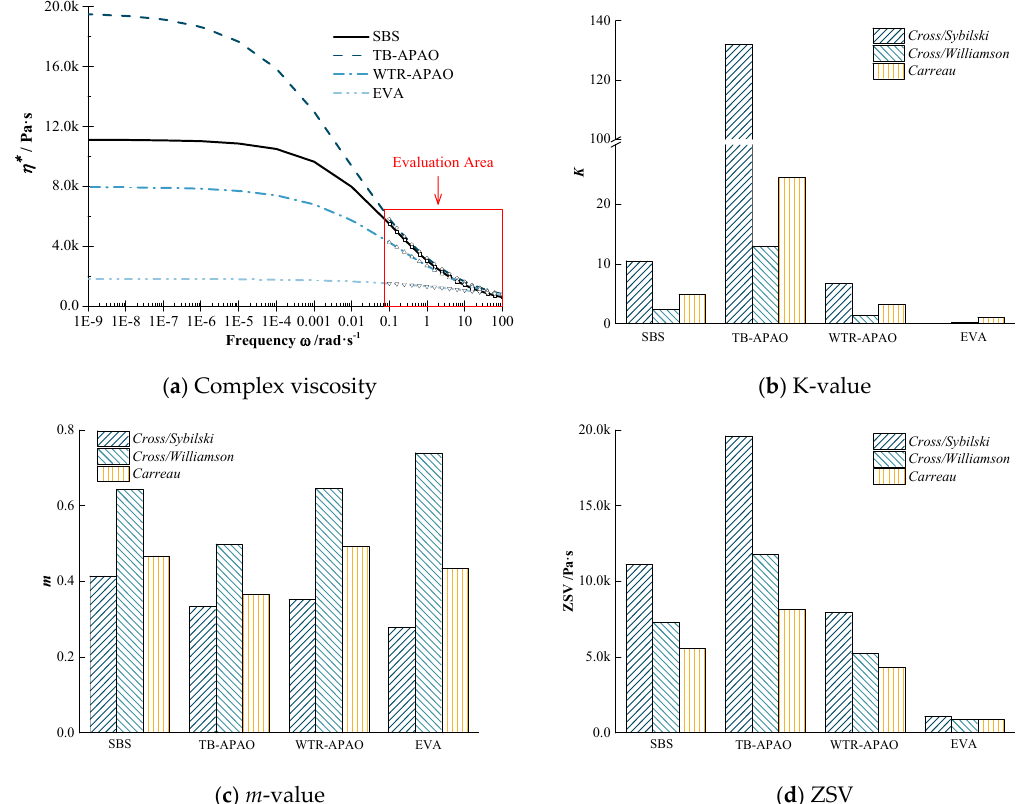
Figure 3. Zero-shear viscosity (ZSV) test results of modified asphalt at 60 °C: ( a ) complex viscosity, ( b ) K -value, ( c ) m -value, and ( d ) ZSV.